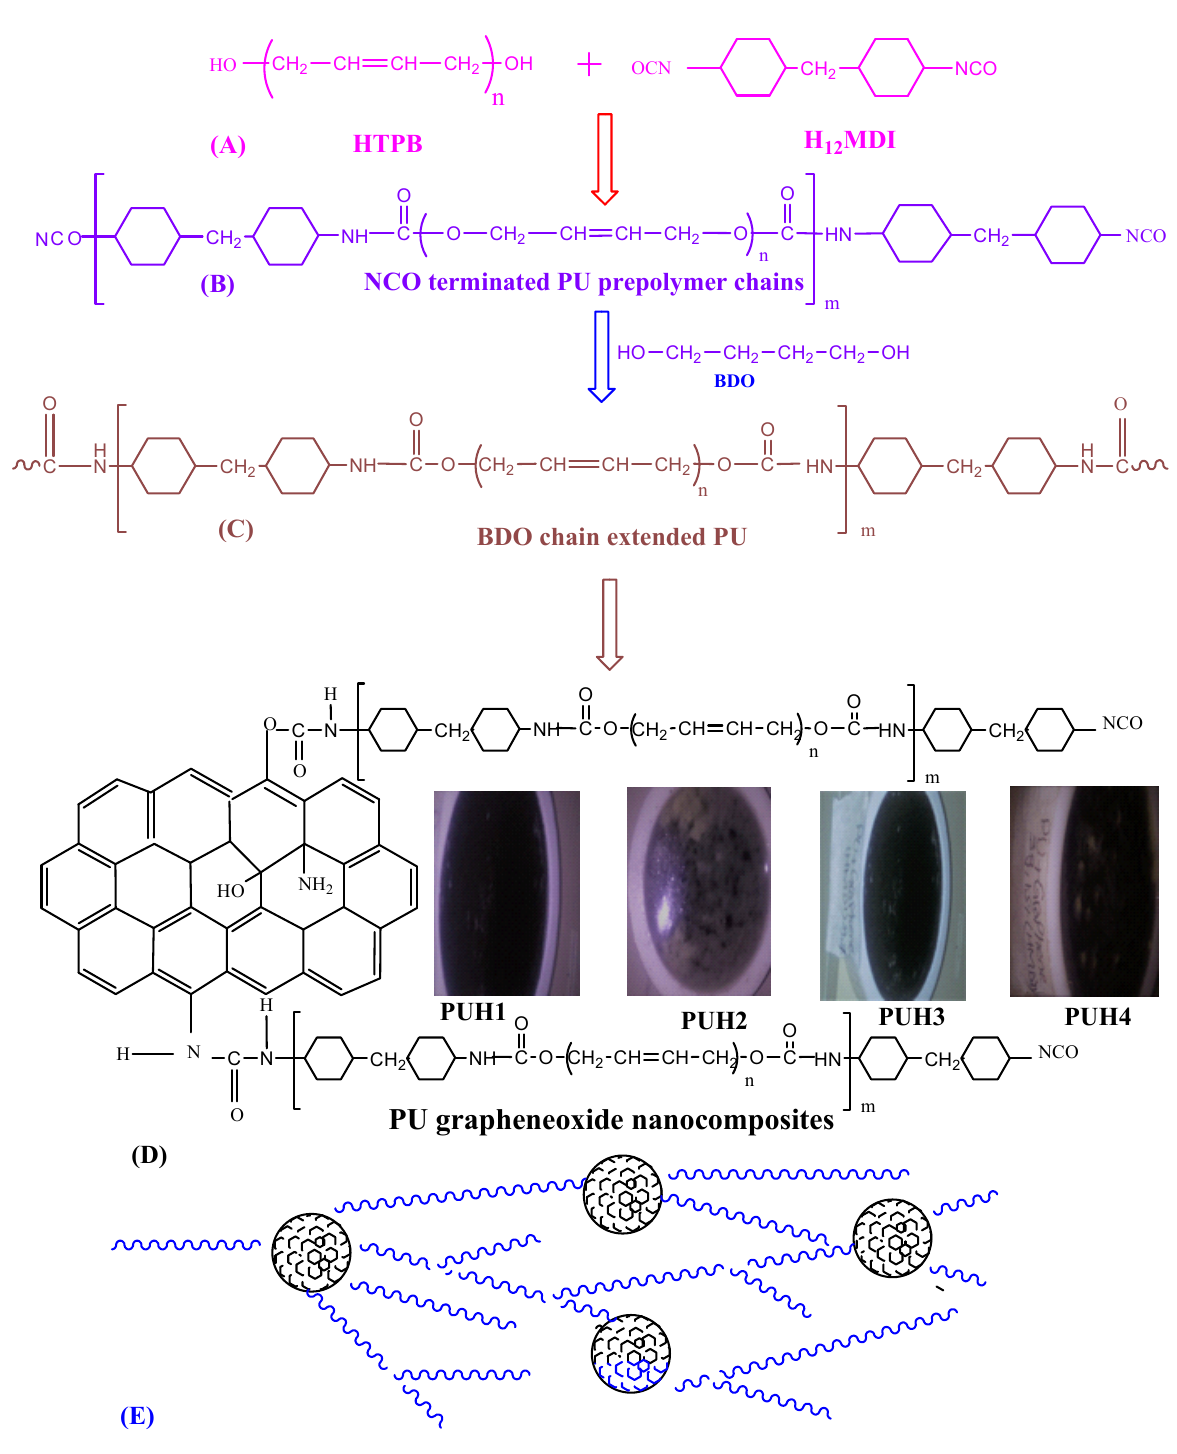
Figure 1. Synthetic route for the development of polyurethane and composites of the PUM and PUH series. ( A ) Addition of monomers ( B ) Formation of NCO terminated PU pre polymer chains ( C ) Polyurethane chain ex-tension with BD ( D ) Formation of graphene oxide nanocomposites ( E ) Morphology of graphene oxide induced nanocomposites.